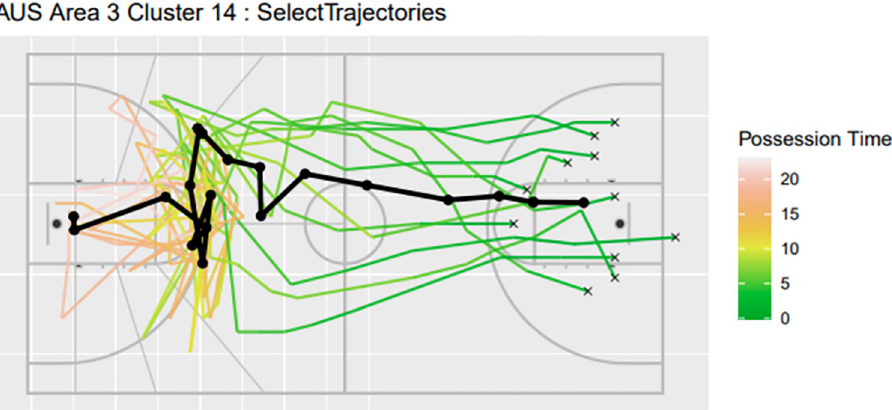
Fig 6. Temporal Trajectorial plots for Australia Area 3 Cluster